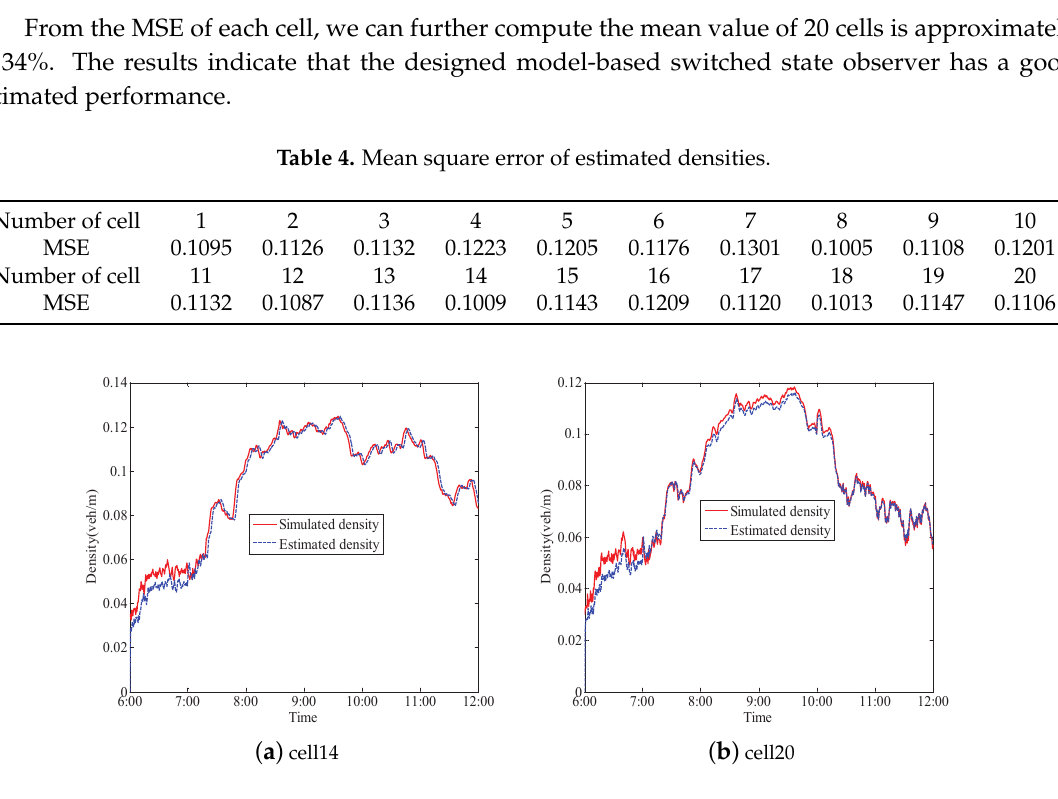
Figure 10. Simulated and estimated densities of cells 14 and